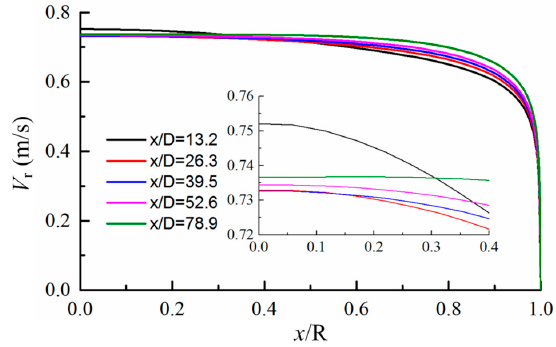
Figure 12. Distribution of the axial velocity ( q/G = 0.0547562).